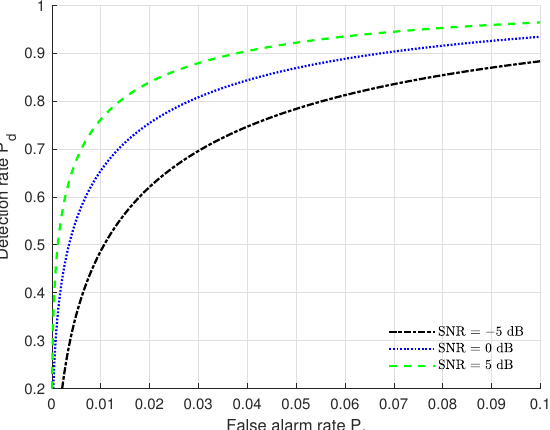
Figure 2. ROC curves under different SNRs with the settings of ( N r = 128, L = 20, k φ = 2 dB, k θ = 2 dB, k α = 2